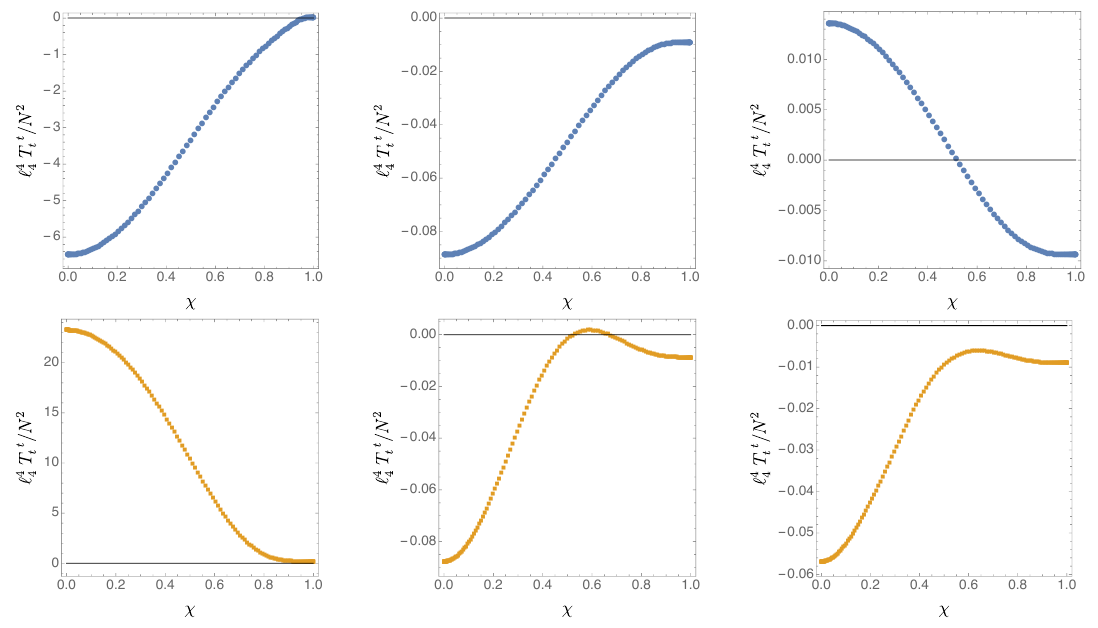
Figure 9 . Boundary stress energy tensors for funnels (top row) and droplets (bottom row). On the top row we show results for two fat funnels with of (cid:12)gure 6; i.e., less thin) thin funnel with row we show the (unique) droplets with p with (cid:26) = 0 : 5207.